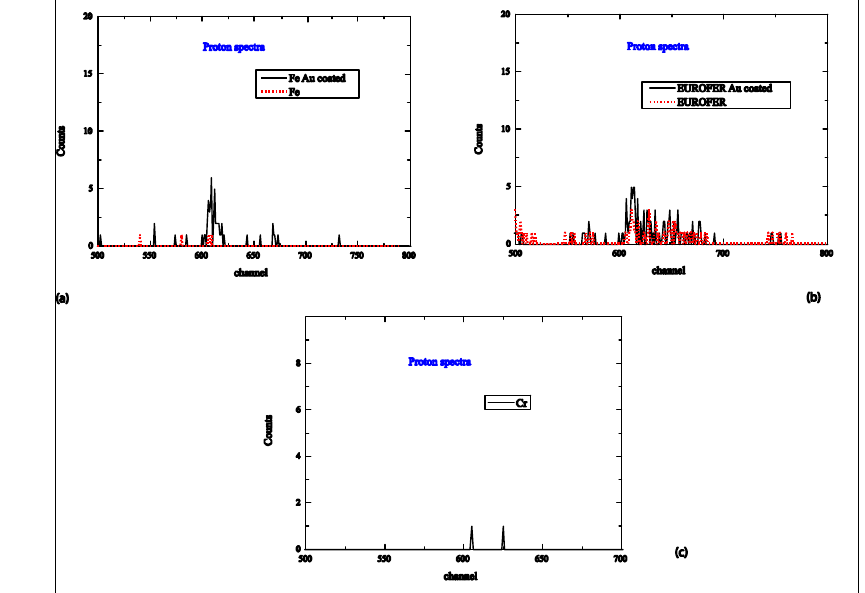
Figure 6 – Proton spectra from (a) the back side of the Fe samples, coated with a 130 nm thick Au layer (-) and pure (---), (b) the back side of the EUROFER samples, coated with a 130 nm thick Au layer (-) and pure (---), (c) back side of the Cr sample (-) Slika 6 – Protonski spektar sa (a) zadnje strane uzorka Fe, obloženog slojem Au debljine 130 nm (-) i č istog Fe uzorka (---), (b) zadnje strane uzorka EUROFER-a, obloženog slojem Au debljine 130 nm i č